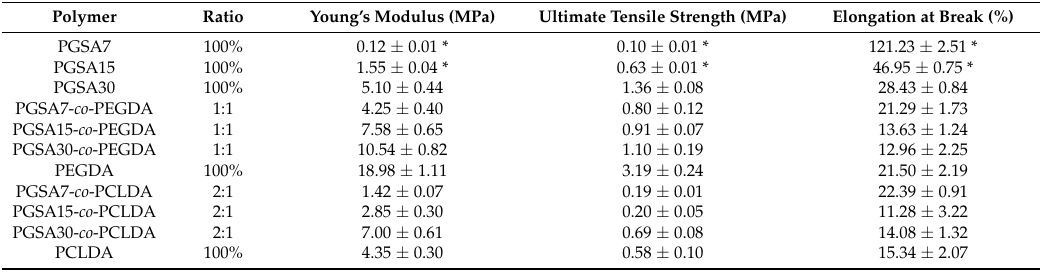
Table 2. Mechanical properties of DLP-AM printed PGSA, PEGDA, PGSA- co -PEGDA, and PGSA- co -PCLDA with various degrees of acrylation in comparison to PEGDA and PCLDA ( n = 5).